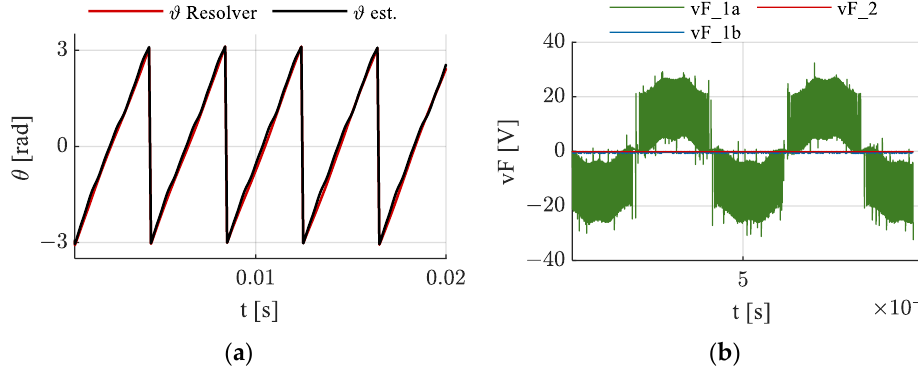
Figure 14. Steady-state three-phase operation: ( a ) electrical rotor position measured by resolver and estimated from back-EMF voltages D, E and F; ( b ) oscilloscopic record of the measured voltage.